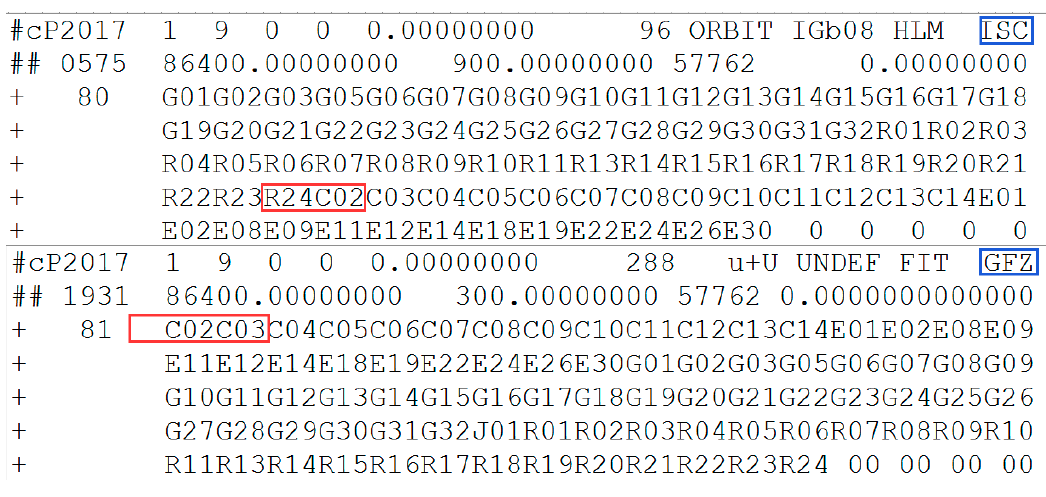
Figure 7. Information of precise orbit products from International Global Navigation Satellite System (GNSS) Monitoring and Assessment System (iGMAS) and German Research Centre for Geosciences (GFZ) on 9 January 2017. The red box highlights the satellite removed from the header of precise orbit products. The blue box marks the abbreviation of the organization providing the products.